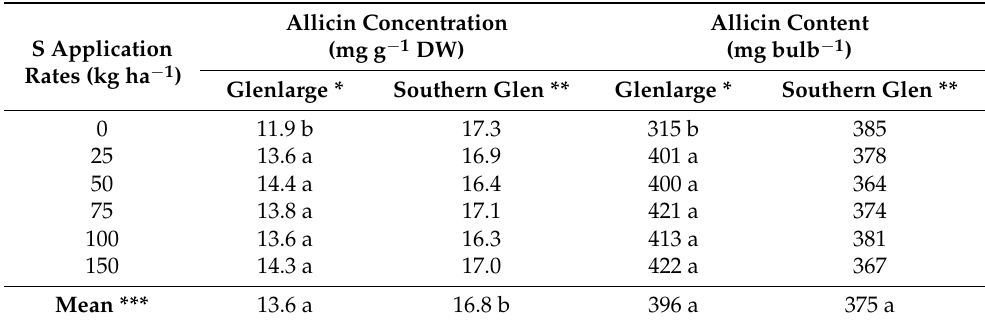
* For cultivar Glenlarge, values in columns followed by different letters are significantly different at p = 0.05; ** Treatment effects were not significant ( p > 0.05); *** Significant differences ( p = 0.05) in mean allicin between cultivars are denoted by the different letters.